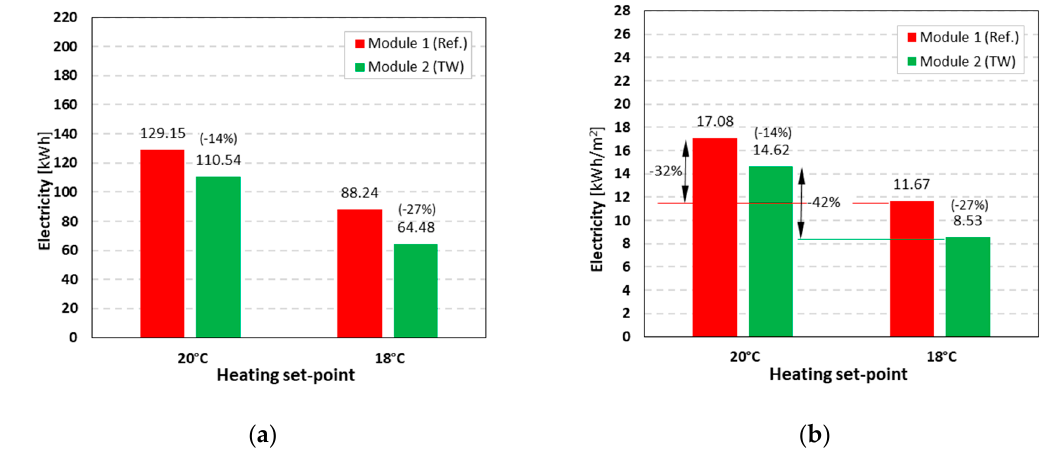
Figure 12. Predicted heating energy consumption (electricity) during the winter season in Coimbra (Portugal), assuming office space use, for two different heating set-points: ( a ) Total values; ( b ) Normalized values.